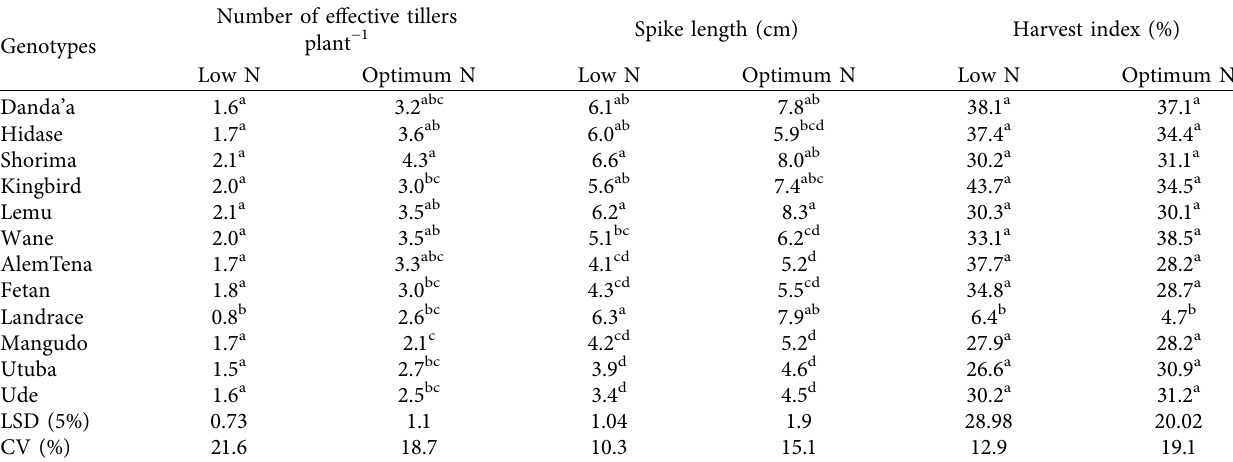
Table 2: Number of effective tillers, spike length, and harvest index of wheat cultivars under low and optimum N supply.